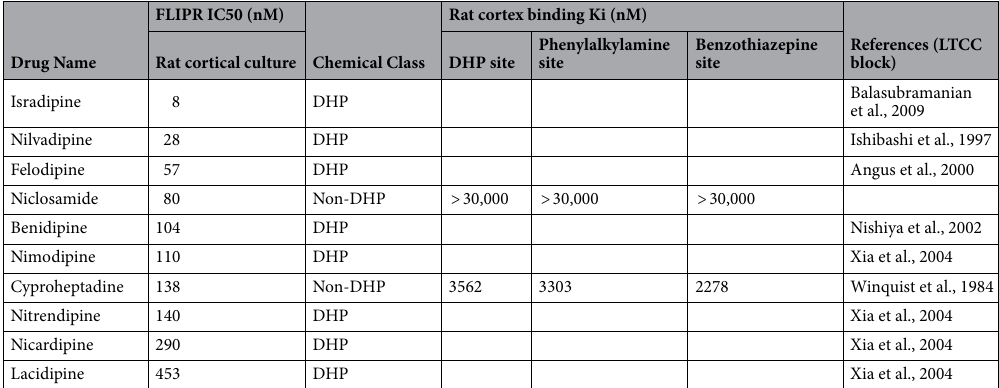
Table 1. Top 10 primary hits from the PW library by potency. IC 50 values (nM) are from the phenotypic calcium flux assay using rat cortical cultures. K i values (nM) are from binding studies using rat cortical